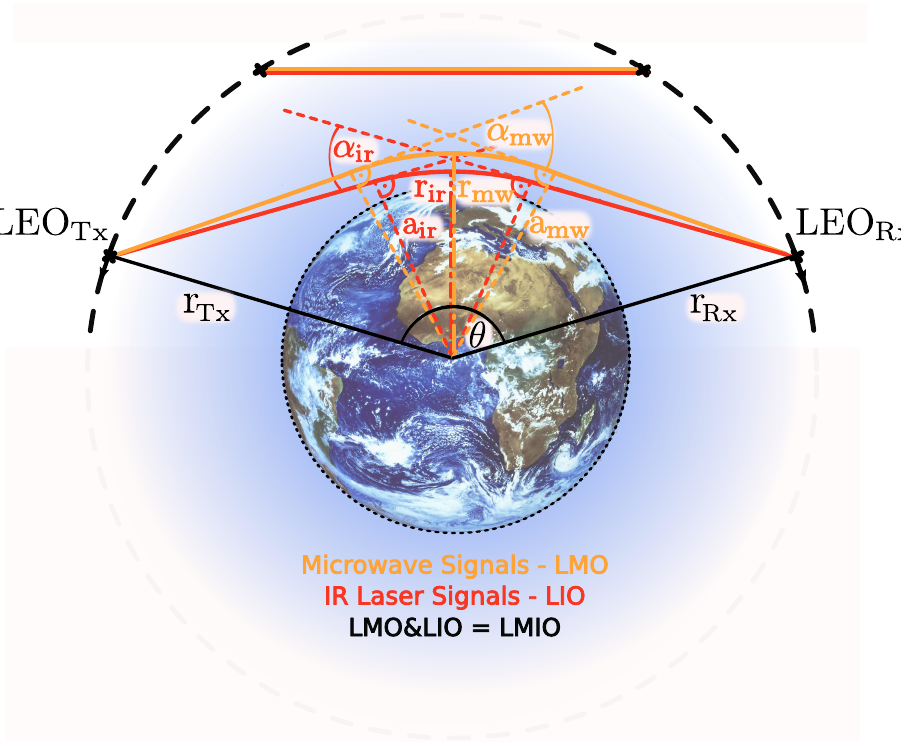
Fig. 1. Schematic view of the LEO-LEO microwave and infrared-laser occultation (LMIO) measurement geometry, as a combination of LMO signals (MW, orange signal paths) and LIO signals (IR, red signal paths) which pass the vacuum as straight lines and are refracted by the atmosphere. Characteristic MW and IR parameters defining this geometry are marked; see the text in Sect. 2.1 for further explanation.